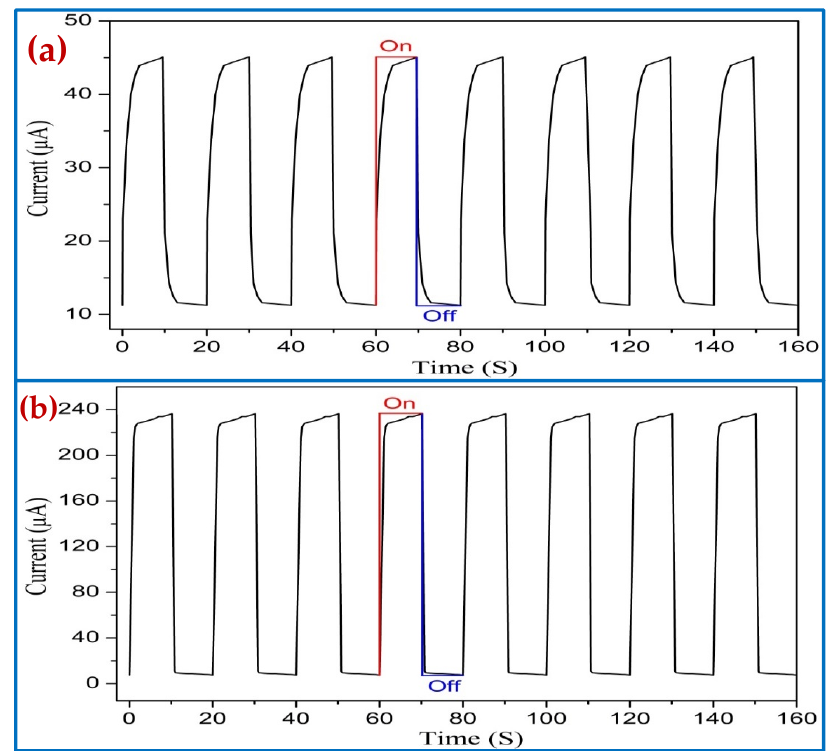
Figure 19. Repeatability properties (on/off) of the Al/ZnO nanorods’ UV PDs under pulsed UV light (380 nm) for optimum growth duration of 4 h: ( a ) no air bubbles and ( b ) air bubbles. The rise (response) time represents the time of the current to grow from 10% to 90% of its saturation value, while the fall (recovery) time signifies the time for the current to decrease from 90% to 10% of its overload value of UV PDs for the two cases, as shown in Table 3. At a 5 V bias voltage, the UV photodetector grown with air bubbles showed a faster response (rise) and fall (recovery) times of 0.9684 s and 0.5037 s, respectively, com- pared with that with no air bubbles. One complete photoresponse cycle shows the photo- current rise and fall edges of UV PDs, as shown in Figure 20.